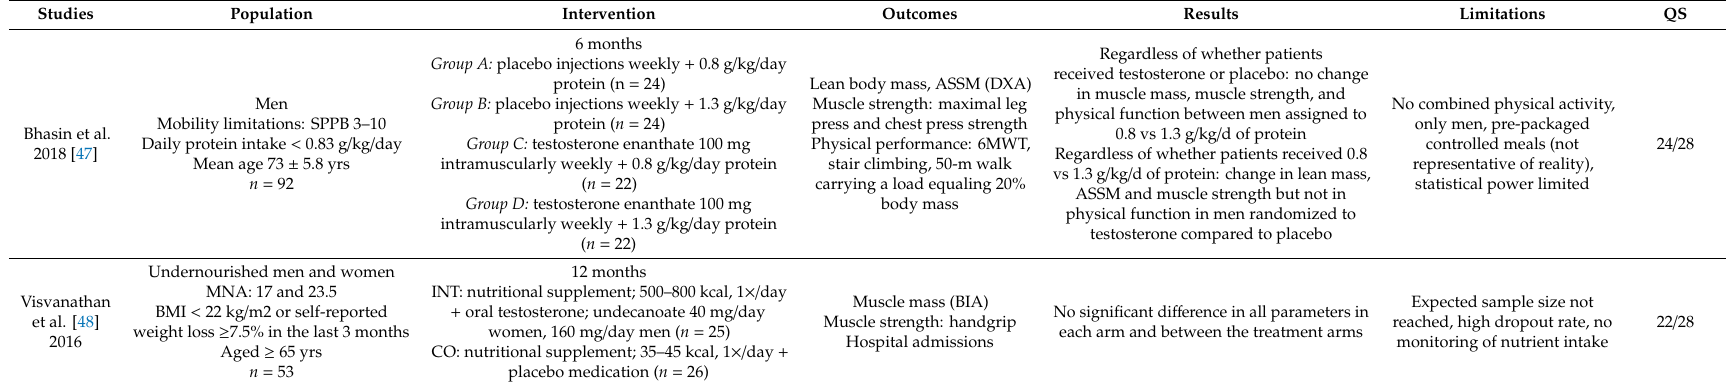
Table 3. Combined nutritional and testosterone therapy interventions in community-dwelling older adults.